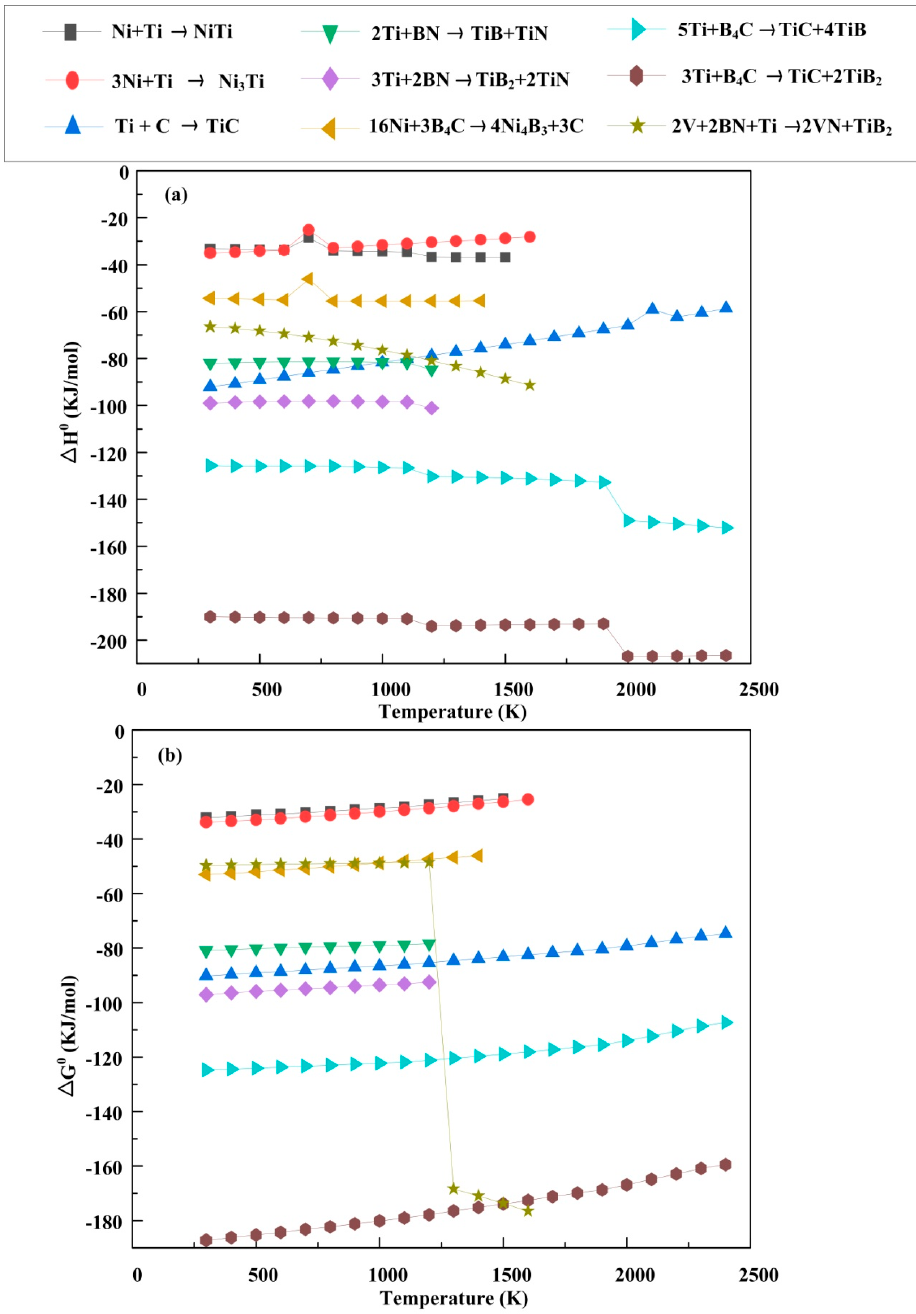
Δ Δ Figure 7. ( a ) ∆ H 0 and ( b ) ∆ G 0 of the latent reactions in Ni–(V/Co)–Ti–B 4 C–BN systems with the Figure 7. ( a ) H 0 and ( b ) G 0 of the latent reactions in Ni–(V/Co)–Ti–B 4 C–BN systems with the change of temperature change of temperature (K).